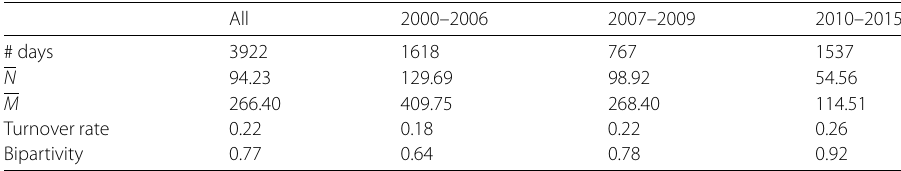
Table 2 Summary statistics of the daily interbank networks. N and M denote the average numbers of active banks and edges in the daily networks, respectively. The turnover rate is the average of the Fig. 1(c) for a description of